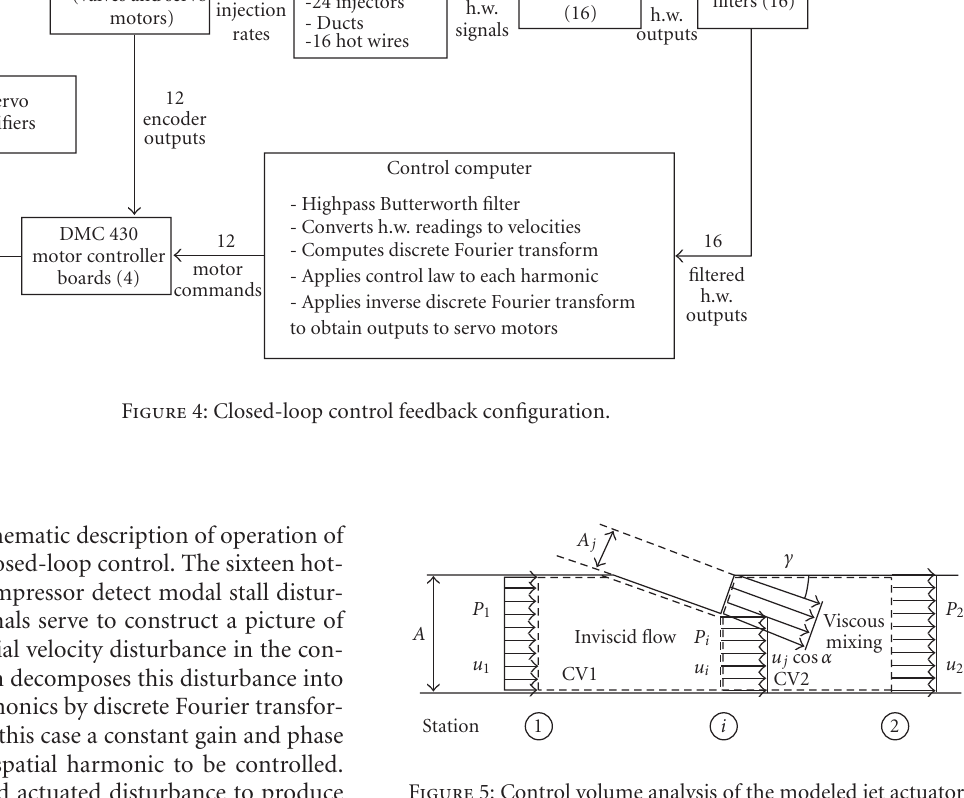
Figure 5: Control volume analysis of the modeled jet